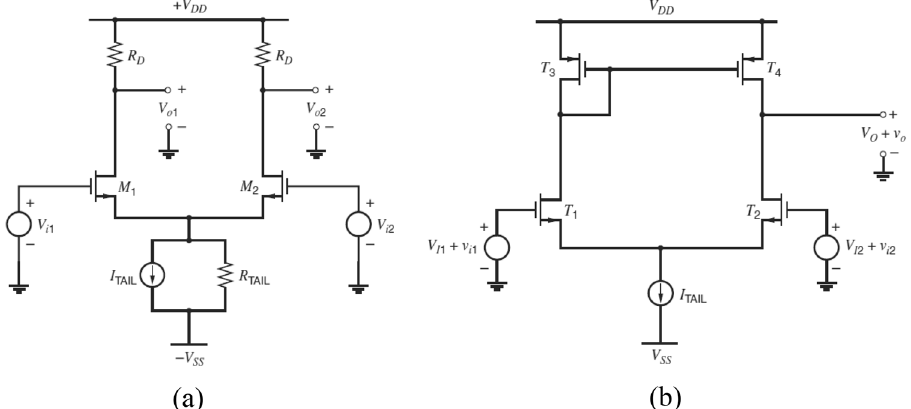
Fig. 1 a Resistive-loaded, b active-loaded differential amplifier